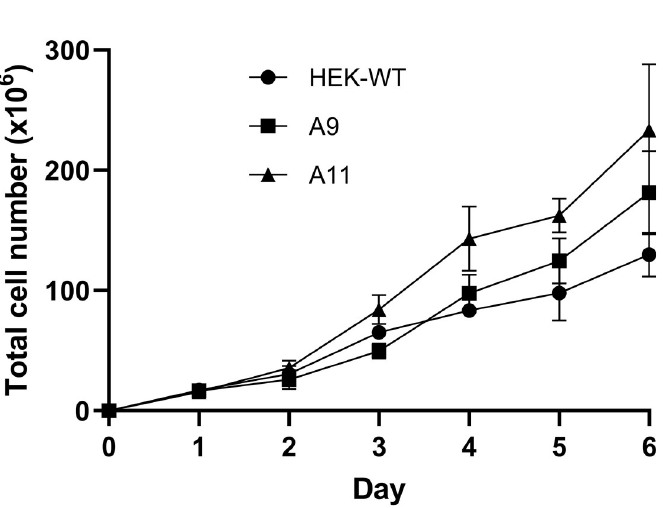
Fig 6. A11 clone has a significantly higher proliferation rate compared to HEK-WT. A11 has a higher proliferation rate compared to HEK-WT starting at day 3 (p < 0.05). There is no statistically significant difference in rate of proliferation between A9 and